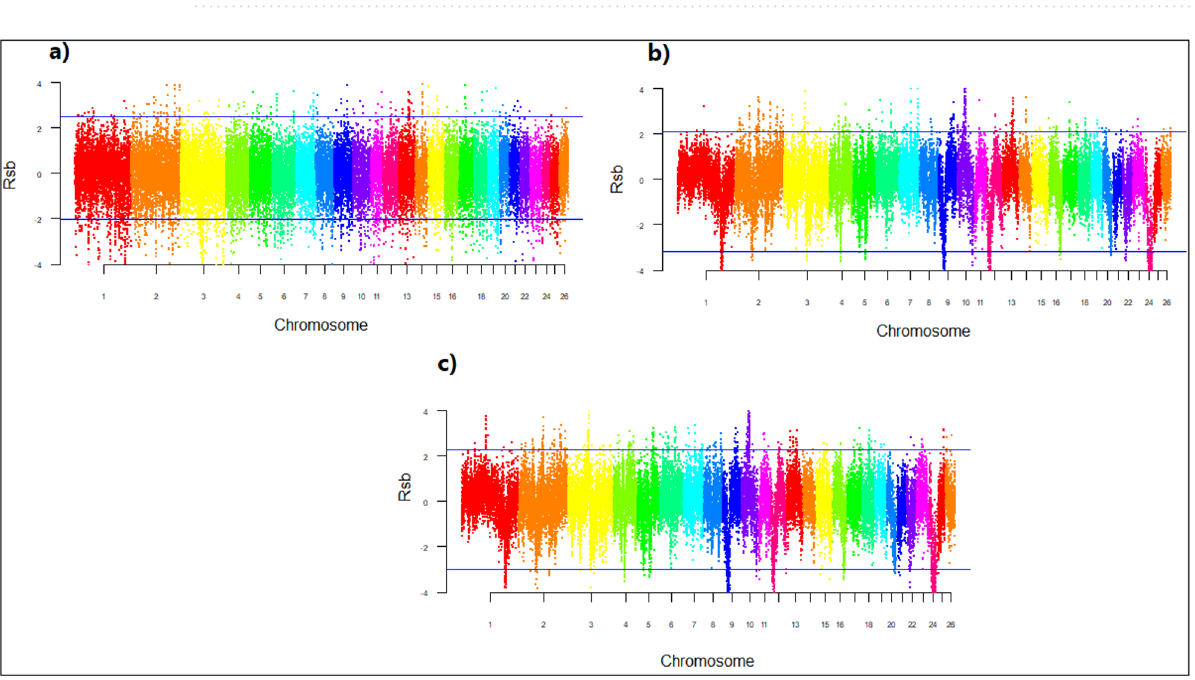
Figure 6. Genomic distribution of standardized haplotype differentiation (Rsb) scores on 26 sheep autosomes pairwise: ( a ) IR and IN breeds, ( b ) IR and AF breeds, ( c ) IN and AF breeds. For breed abbreviations, see Table